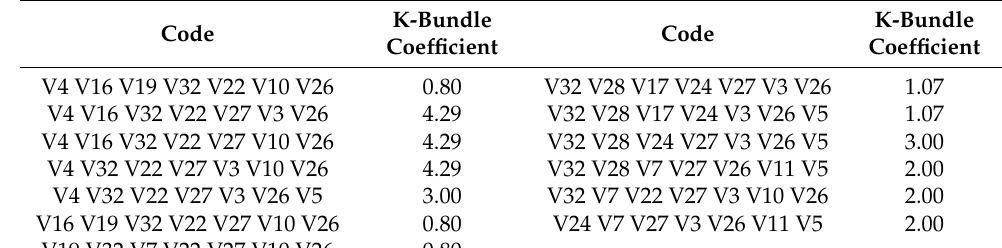
Table 7. K-cluster analysis of the network.